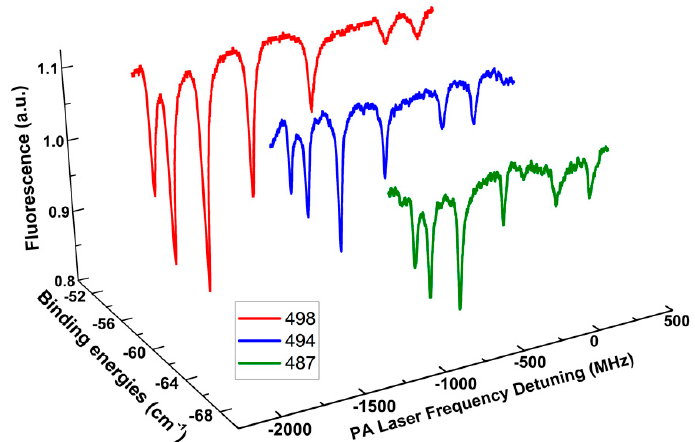
Figure 3. BPAS of the vibrational levels ˜ v = 498, 494 and 487 of ultracold Cs 2 0 + u (6S 1 / 2 + 6P 1 / 2 ) long-range state. The spectroscopy data have been extended to a red detuning of nearly ~70 cm − 1 below the 6S 1 / 2 + 6P 1 / 2 dissociation limit.